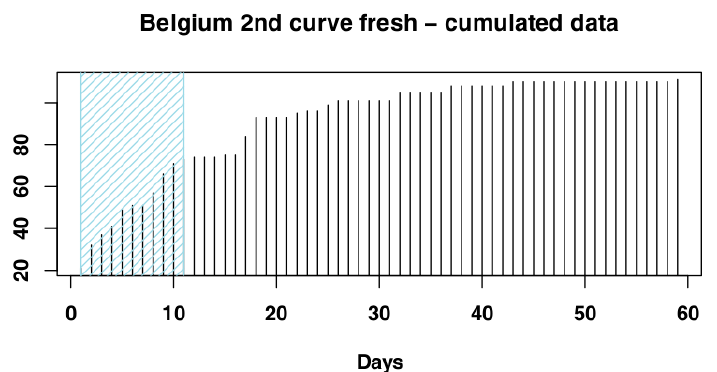
Figure 6. Selected subset for Belgium data.